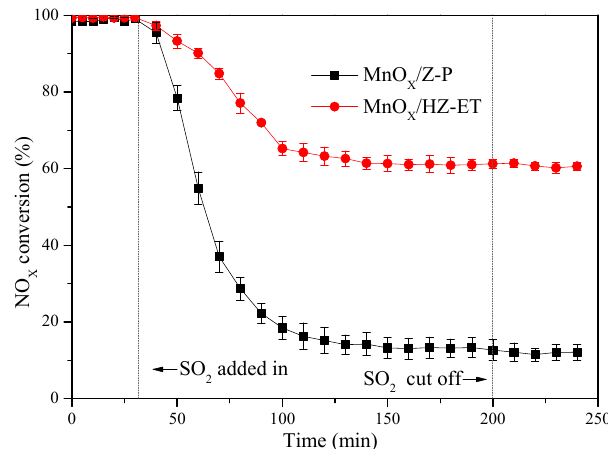
Figure 8. The SO 2 tolerance tests over the MnO x /HZ-ET and MnO x /Z-P; reaction conditions: 800 ppm NH 3 , 800 ppm NO, 100 ppm SO 2 , 5 vol. % O 2 , Ar to balance, gas hourly space velocity (GHSV) = 40,000h − 1.